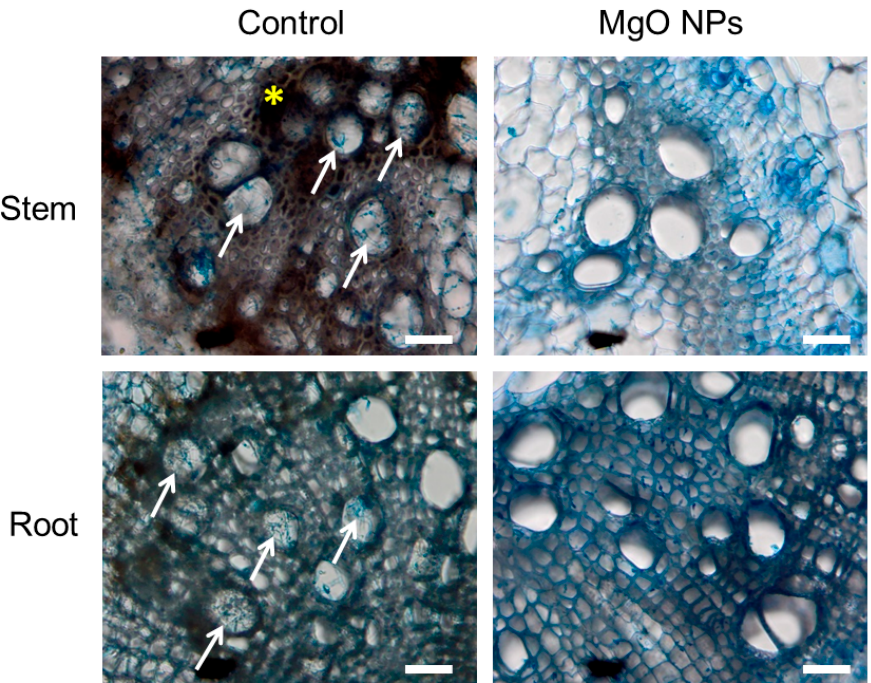
Figure 9. Microscopy images of tomato stems (10 cm above ground) and main roots 21 days after inoculation with Fusarium oxysporum f. sp. lycopersici . Cross sections of each tissue were stained with lactophenol cotton blue. White arrows point to the mycelial masses of F. oxysporum f. sp. lycopersici . Asterisk indicates the dark brown discoloration of vascular bundles. Scale bars represent 100 μ m.